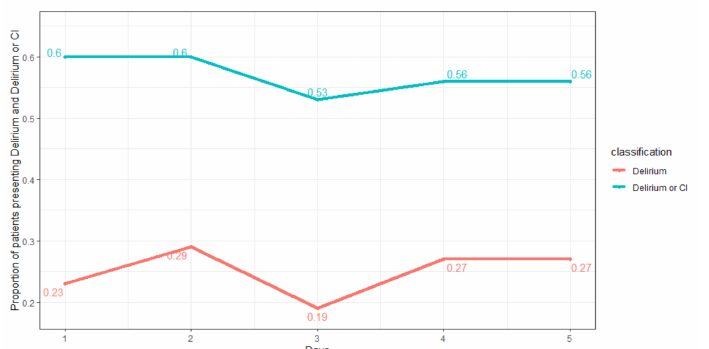
Figure 1. Proportions of patients reporting delirium and risk for delirium during the first five days of hospitalization. The delirium state indicates a 4AT score higher than 4; the delirium or cognitive impairment (CI) state indicates a 4AT score higher than